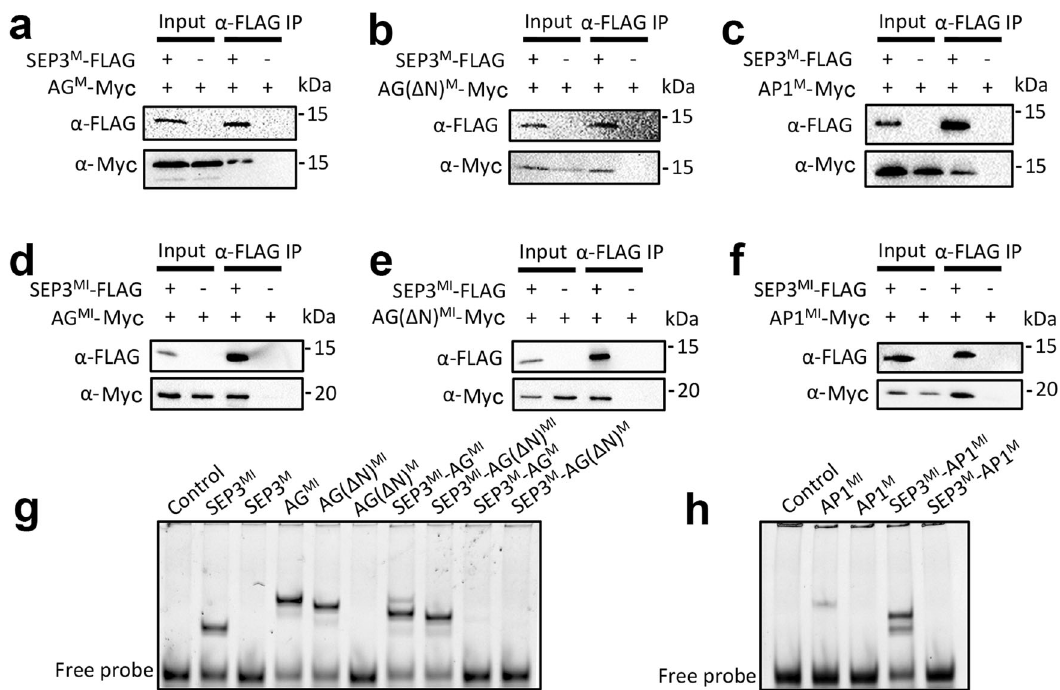
Fig. 3 Type II MADS TFs require the I domain for DNA binding but not dimerisation. a – c Pull-down assay showing that the M domain of SEP3 (SEP3 M ) interacts with the M domains of AG (AG M ), AG with the fi rst 16 N-terminal amino acids deleted (AG( Δ N) M ) and AP1 (AP1 M ), respectively. d – f Pull-down assay showing that the MI domain of SEP3 (SEP3 MI ) interacts with the MI domain of AG MI , AG( Δ N) MI and AP1 MI , respectively. All assays were performed twice and a representative blot is shown. g , h EMSA assay showing that homodimers from SEP3 MI , AG MI , AG( Δ N) MI and AP1 MI and heterodimers SEP3 MI - AG MI , SEP3 MI -AG( Δ N) MI and SEP3 MI -AP1 MI shift a DNA sequence containing a canonical CArG-box binding site (as per Fig. 2), while their corresponding constructs without the I domain cannot, suggesting that the I domain in type II MADS TFs is required for DNA binding. All EMSAs were performed at least twice and a representative gel is